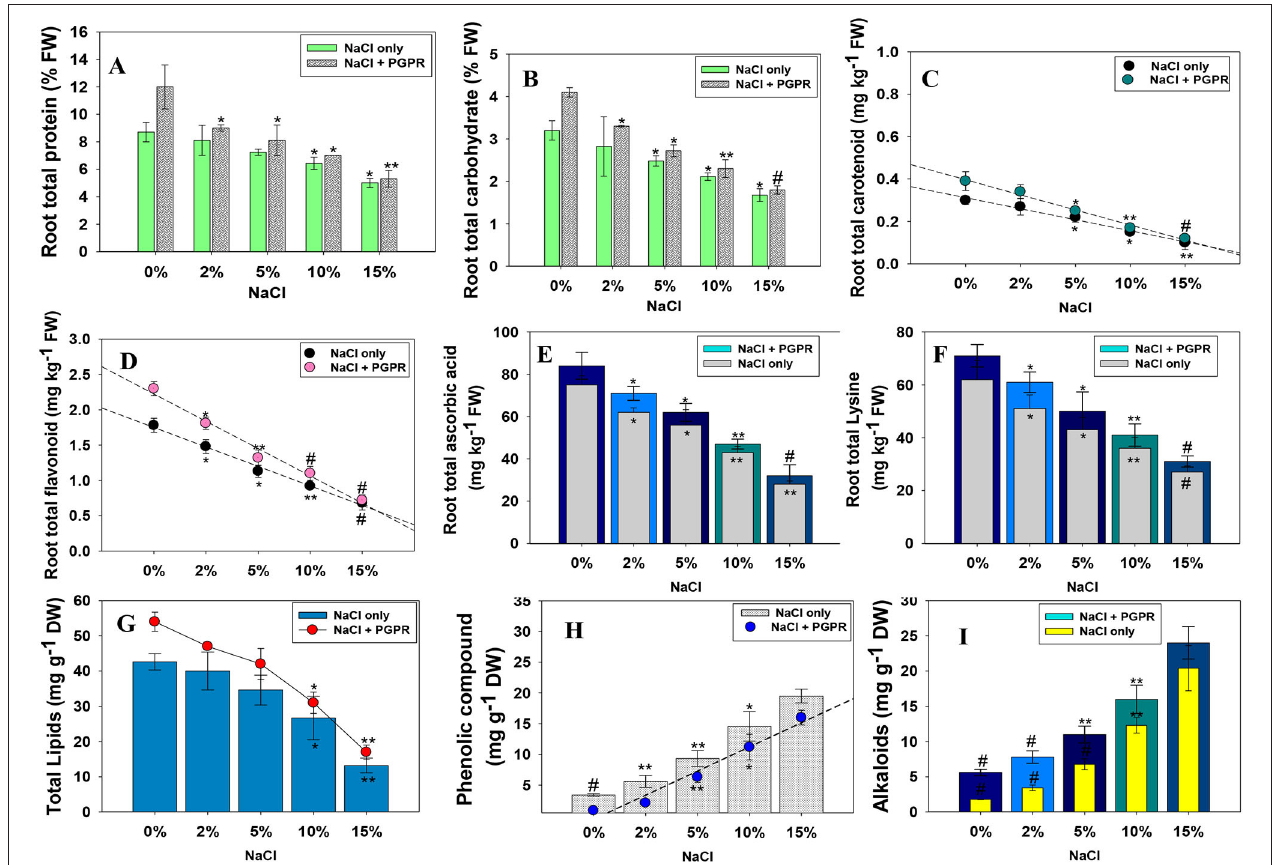
FIGURE 4 | Inoculation impact of halotolerant PGPR strain on root total protein (A) , total carbohydrate (B) , total carotenoid (C) , total flavonoid (D) , ascorbic acid (E) , lysine content (F) , total lipids (G) , total phenolics (H) , and alkaloids (I) extracted from root and foliage tissues of radish plants raised in soils treated with different levels of NaCl. In this figure, bar and line diagrams represent the mean values of three replicates ( n = 3). Corresponding error bars represent standard deviation (SD) of three replicates (SD, n = 3). The asterisks *, **, and # denote statistical significance at p < 0.05, p < 0.005 and p < 0.001, respectively, computed by Student’s T